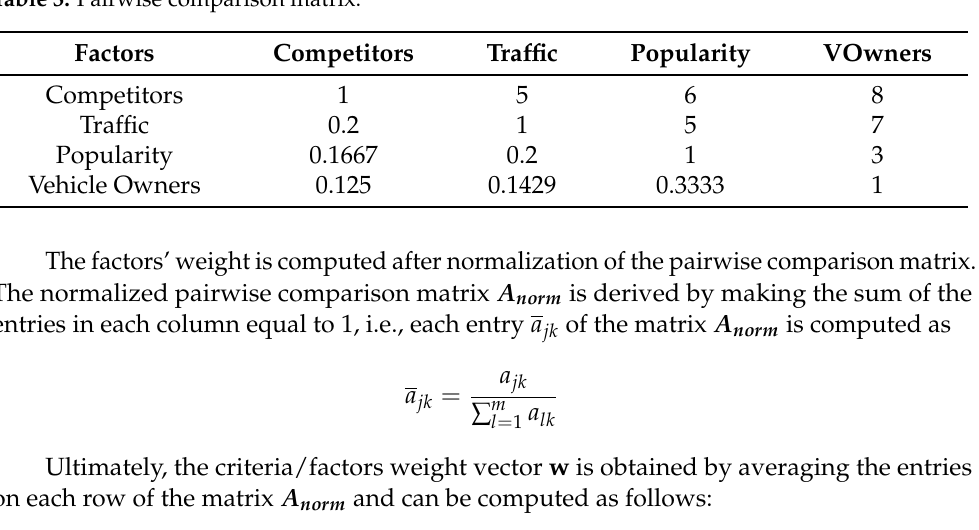
Table 3. Pairwise comparison matrix.